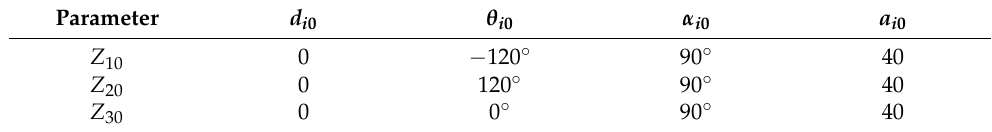
Table 3. D-H parameters for fi nger base coordinates to palm base coordinates . Parameter